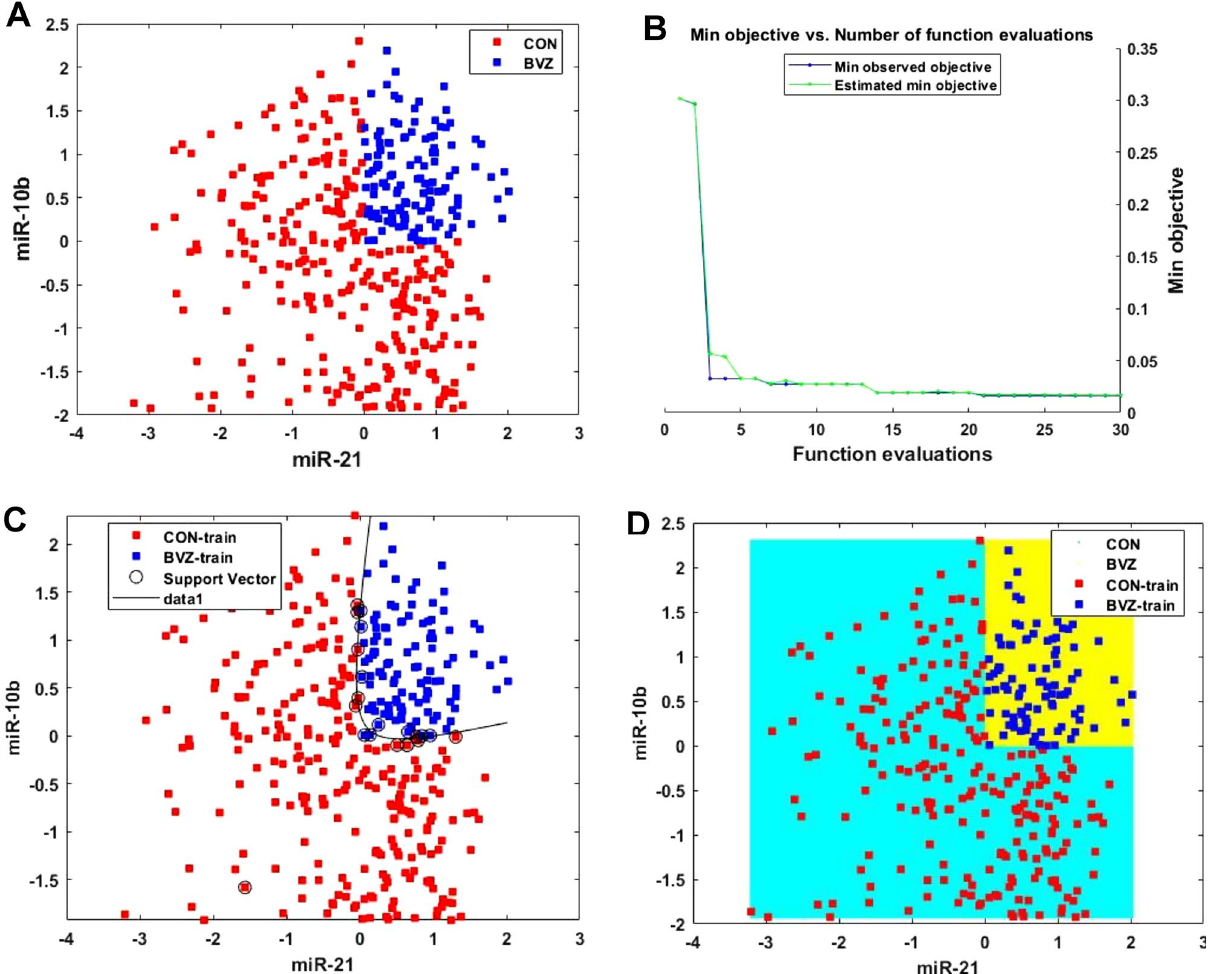
Figure 4. Constructing and comparing some classifiers for GBM BVZ subtypes based on miRNA z-scores of profiling. ( A ) For the z-score data points of the two subgroups, the horizon and vertical axes represent miR-21 and miR-10b. The blue or red dots are the GBM BVZ subgroup or the control subgroup. ( B ) The min. objective vs number of function evaluations during the construction of the SVM classifier. ( C ) The SVM model classifies GBM BVZ subtypes. All dots are the same as above, and the circles are the support vectors used. The curve is the edge of the two subgroups, and the accuracy is 100%. ( D ) The RF algorithm classifies GBM BVZ subtypes. The dots are in the same labels. If a blue or a red dot is in the yellow or cyan region, the prediction is correct; otherwise, it is